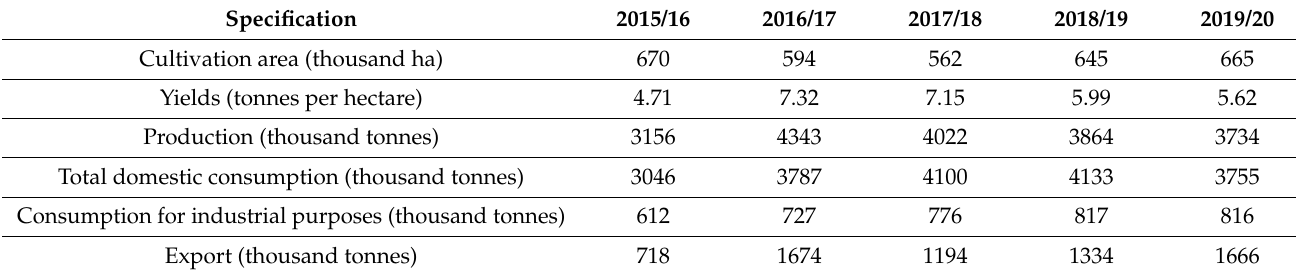
Table 4. Maize balance sheet in Poland [53].